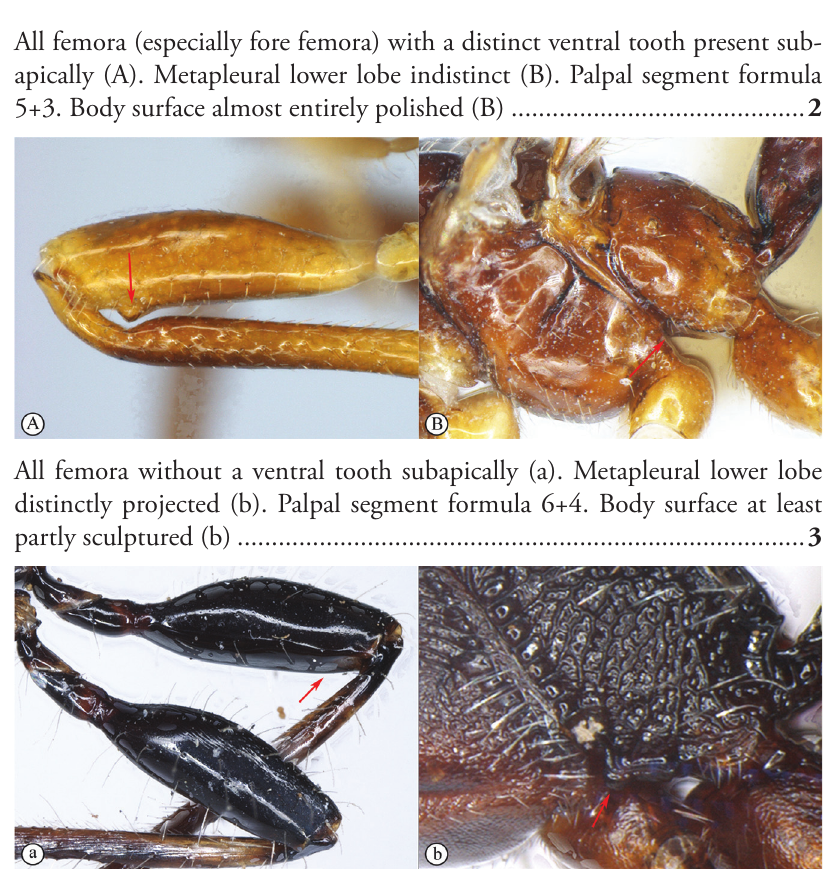
Prepectal (epicnemial) carina present (A). Propodeum without depressions (B). Third to sixth metasomal tergites covered with short setae (C) ............... ................................................................... Termitospathius